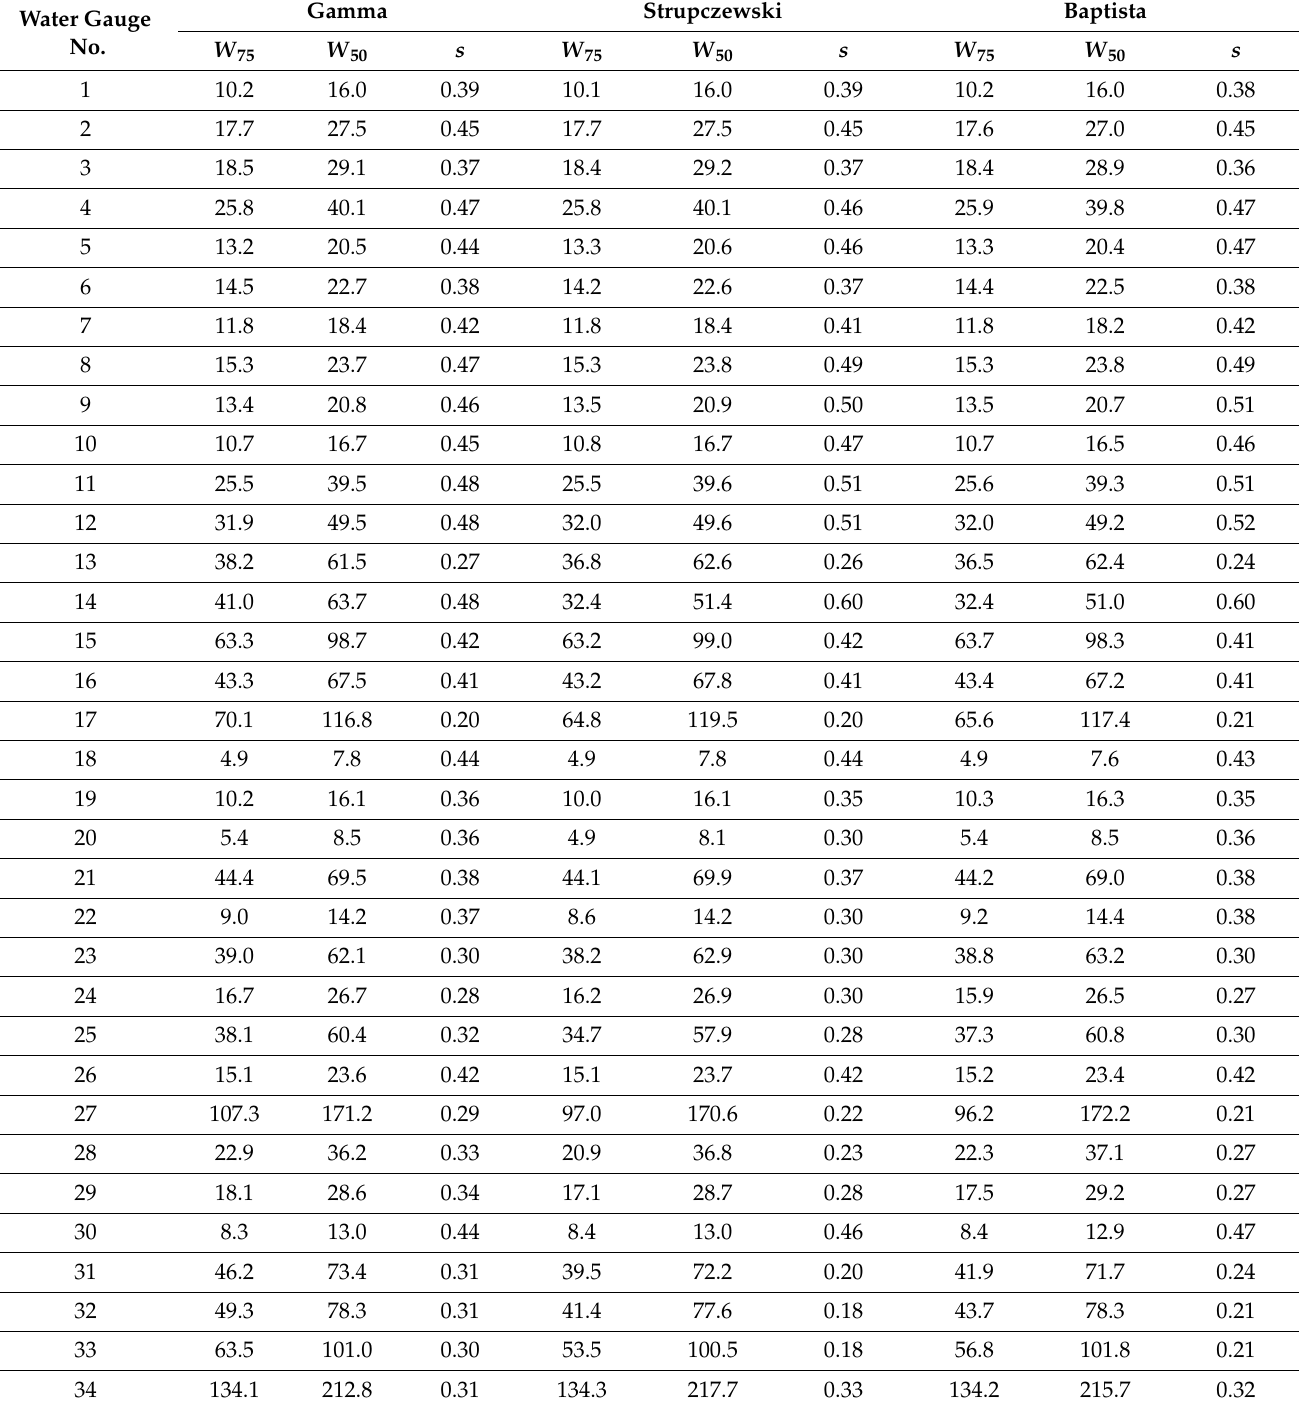
Table 2. The values of parametric DFH characteristics W 50 , W 75 and s estimated with the use of the analyzed methods: Gamma, Strupczewski and